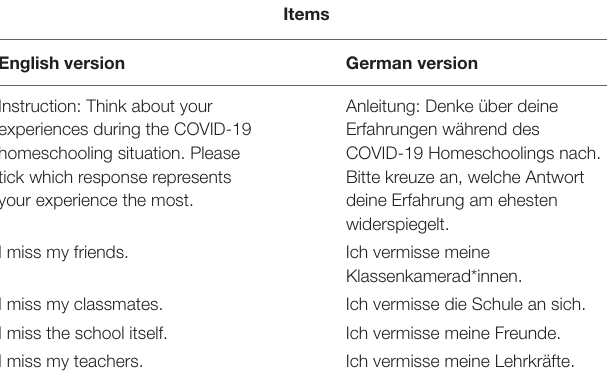
TABLE 1 | Students’ experiences of social distancing scale